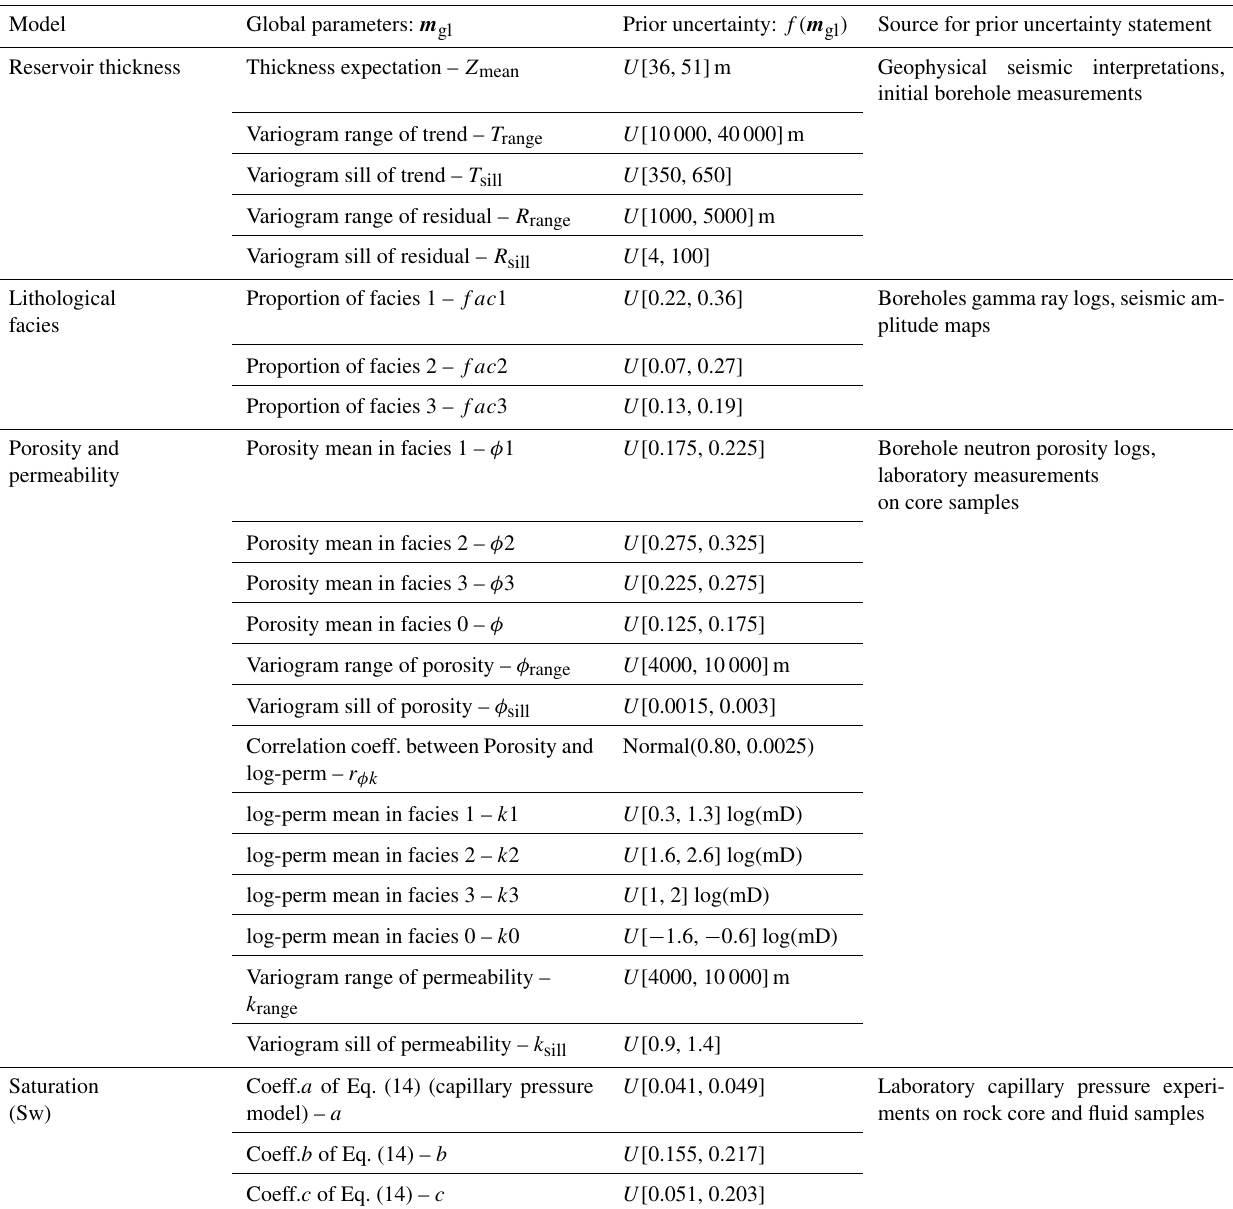
Table 1. The global model parameter m gl and its prior uncertainty distribution f ( m gl ) . The initial prior distributions of the parameters are mostly assumed to be uniform (formulated as U [min, max]) due to limited available